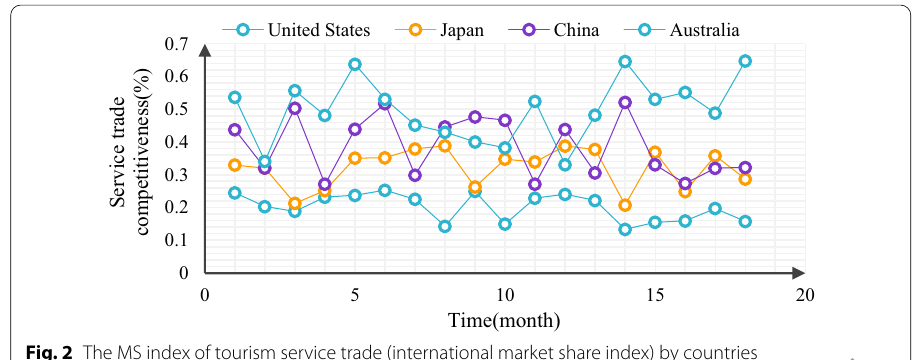
Fig. 2 The MS index of tourism service trade (international market share index) by countries